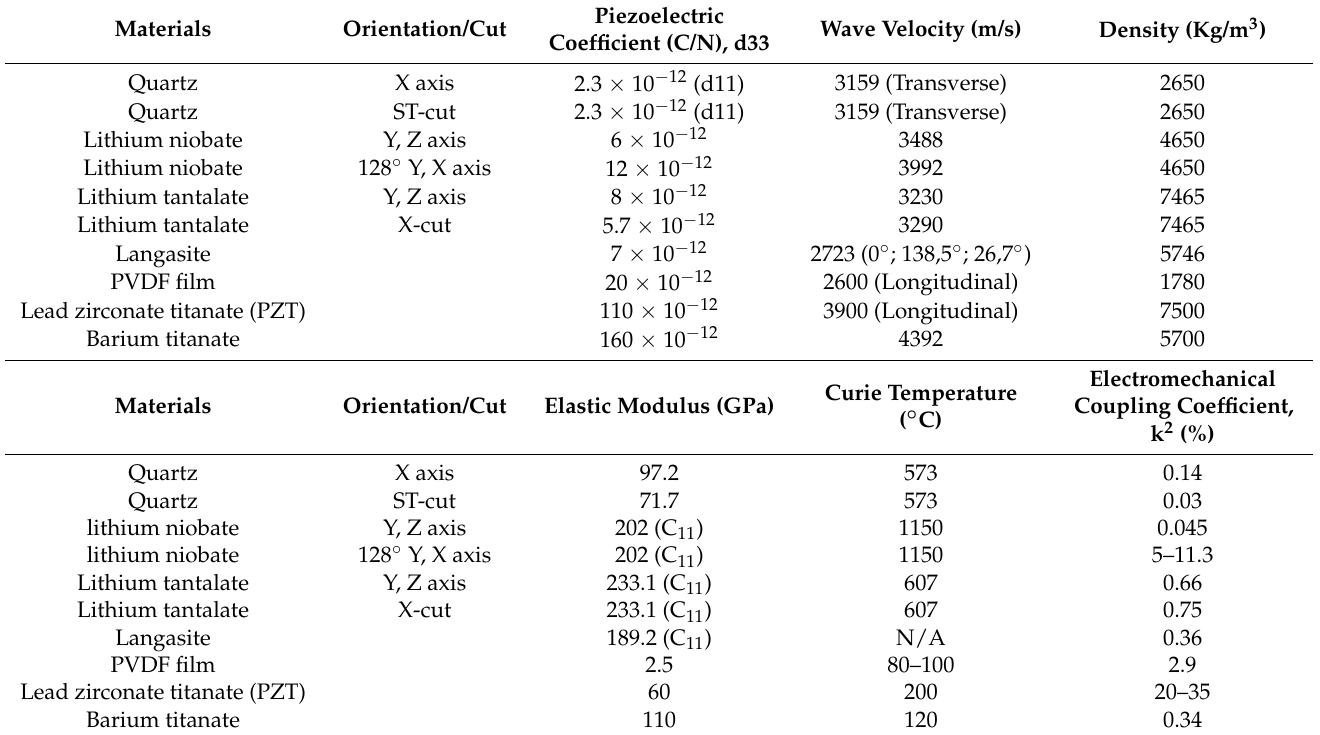
Table 2. Comparison table for the properties of different bulk piezoelectric